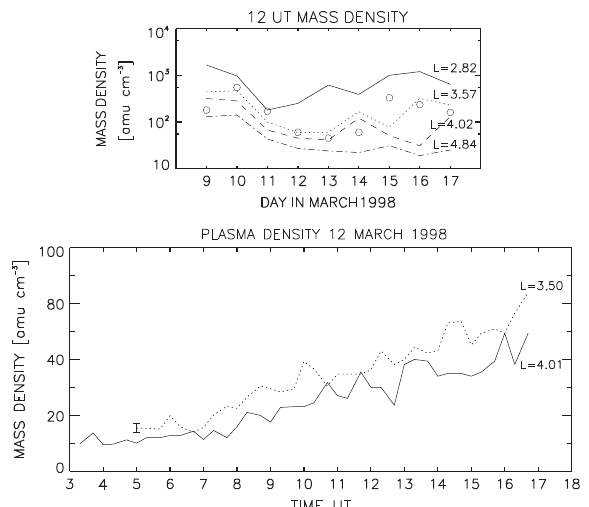
Fig. 6. Top: 12 UT mass densities at selected L values over 9–17 March. Open circles represent plasmapause location given by Moldwin et al. (2002) model. Bottom: detailed view of mass density refilling for two nearby station pairs on 12 March.